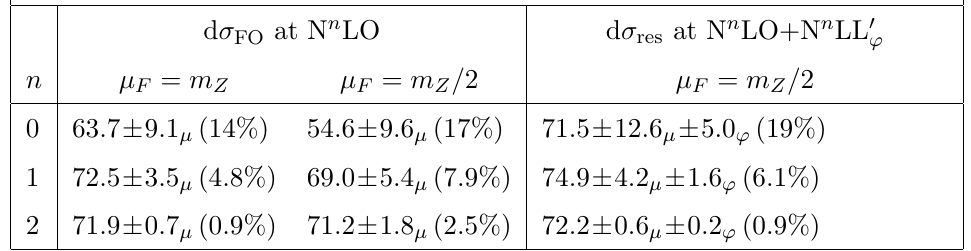
Table 4 . Cross section for pp ! Z=(cid:13) (cid:3) ! ‘ + ‘ (cid:0) at Q = m Z and Y = 0 at the LHC with E cm = 13 TeV. The central scale is always (cid:22) FO = (cid:22) R = m Z . The percent uncertainties for the resummed results correspond to the total uncertainty (cid:1) (cid:22) (cid:8) (cid:1) ’ .